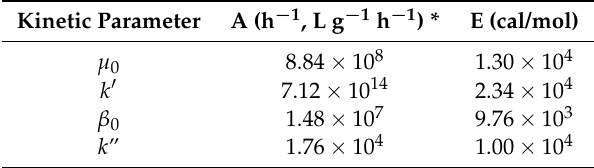
Table 1. List of thermodynamics characteristics for the kinetic parameters [10]. Kinetic